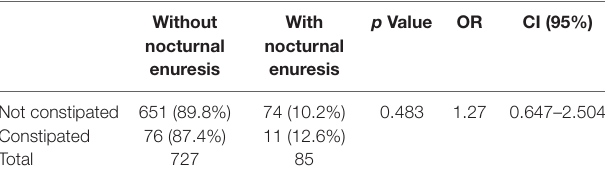
TaBle 5 | correlation between constipation and nocturnal enuresis. Without nocturnal